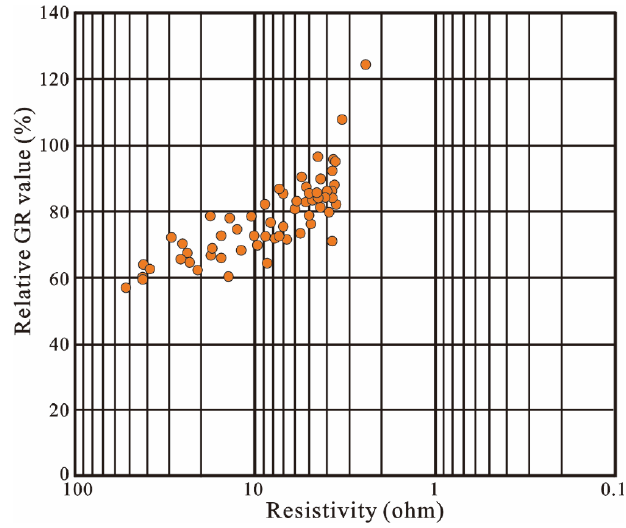
Figure 8. Crossplots of resistivity and relative GR value of P Formation reservoirs.